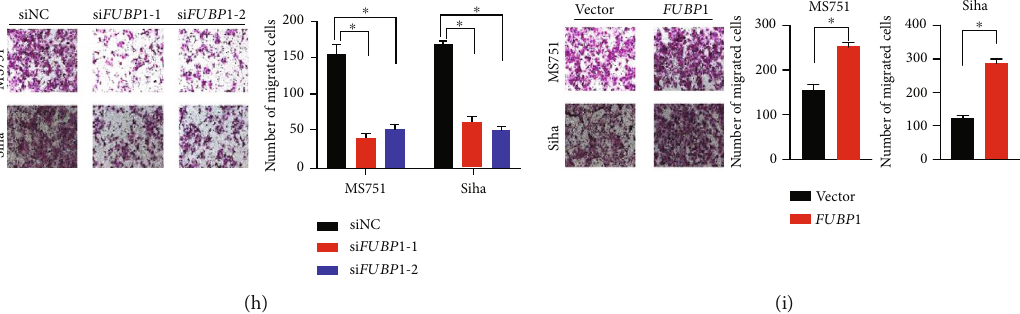
Figure 2: FUBP1 promotes the cell proliferation and migration of CC in vitro. (a, b) The mRNA and protein level in MS751 and Siha after FUBP1 knockdown or overexpression. (c, d) CCK-8 analysis of MS751 and Siha cell viability after FUBP1 knockdown or overexpression. (e, f) Representative colony formation and quanti fi cation number of colonies after FUBP1 knockdown or overexpression. (g) Representative EdU staining image and quanti fi cation ratio of proliferation cells after FUBP1 knockdown. (h, i) Representative transwell assay and quanti fi cation analysis after FUBP1 knockdown or overexpression. Error bars represent mean ± standard error of mean. Scar bar: 50 μ m. Two-tailed t -test, ∗ p < 0 : 05